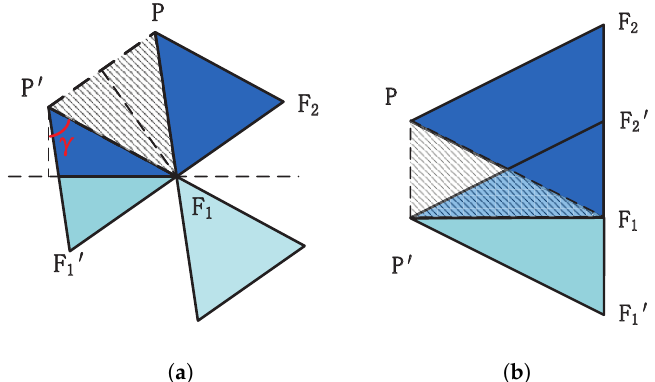
Figure 9. Calculation of COPs. ( a ) XOZ view of the detected area model; ( b ) XOZ view of the detected area model ( γ = 90 ◦